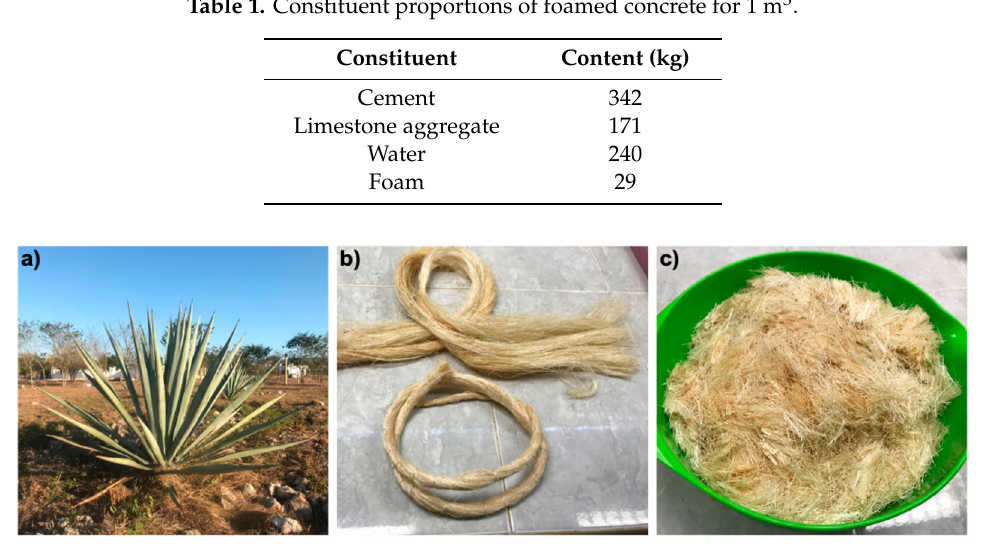
Figure 1. ( a ) Henequen plant; ( b ) henequen fibers and ( c ) henequen fibers chopped to a length of 19 mm. Table 2. Mechanical properties of the henequen [38] and PP [37] fibers.